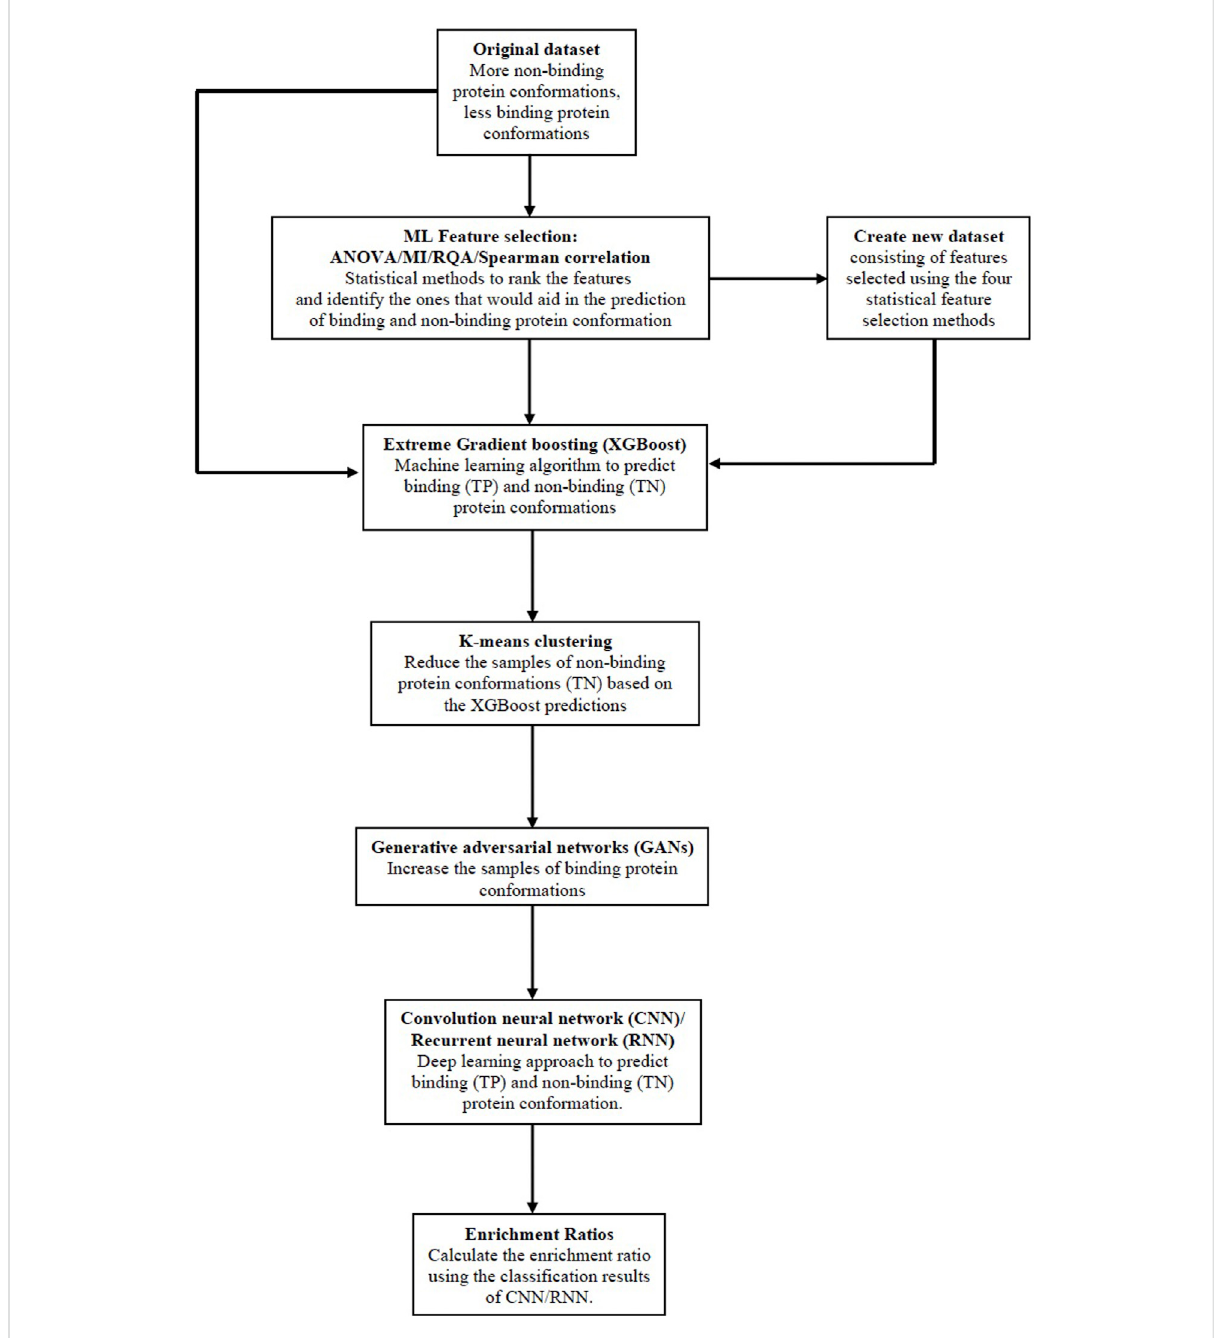
FIGURE 3 The proposed Big Data analytics based AI/ML protein conformation selection/prediction